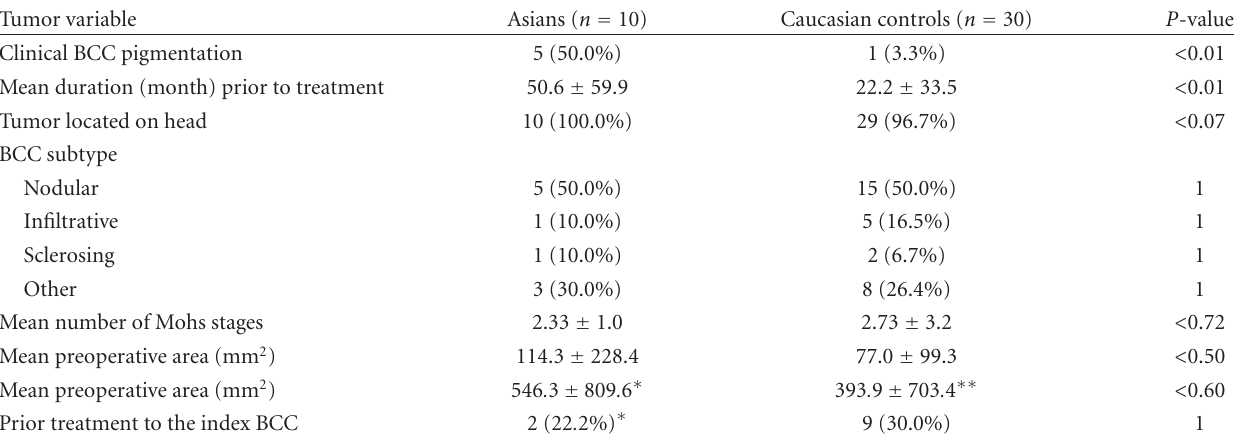
Table 2: Tumor variables.